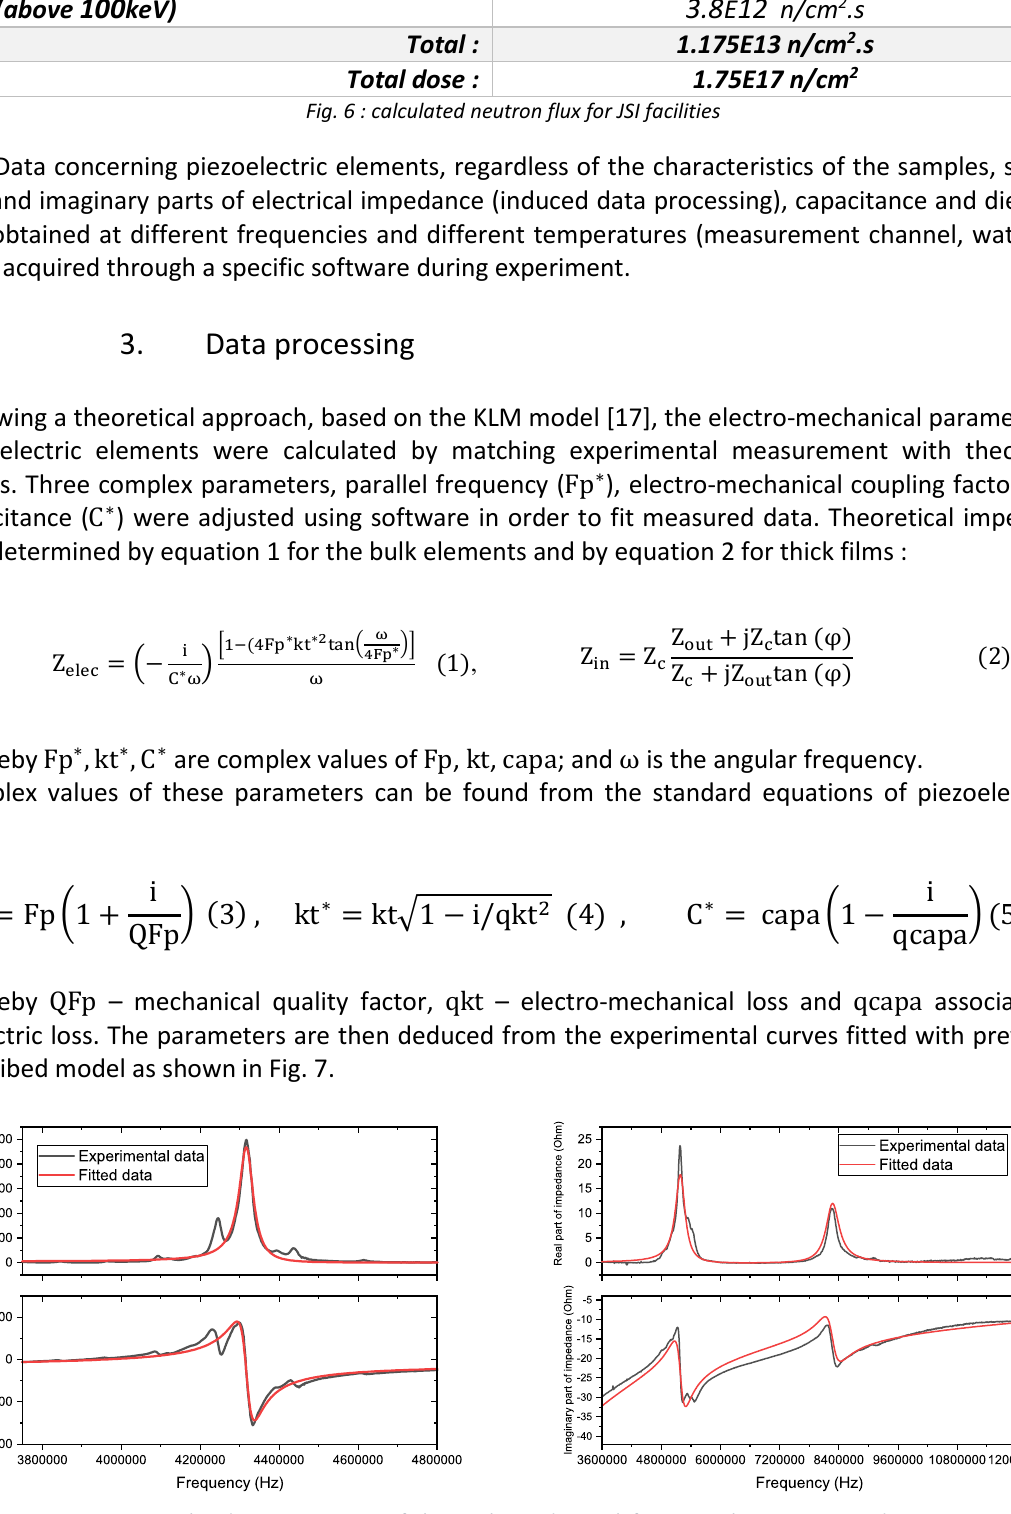
Fig. 7 : real and imaginary parts of electrical impedance : left PZ27, right screen-printed